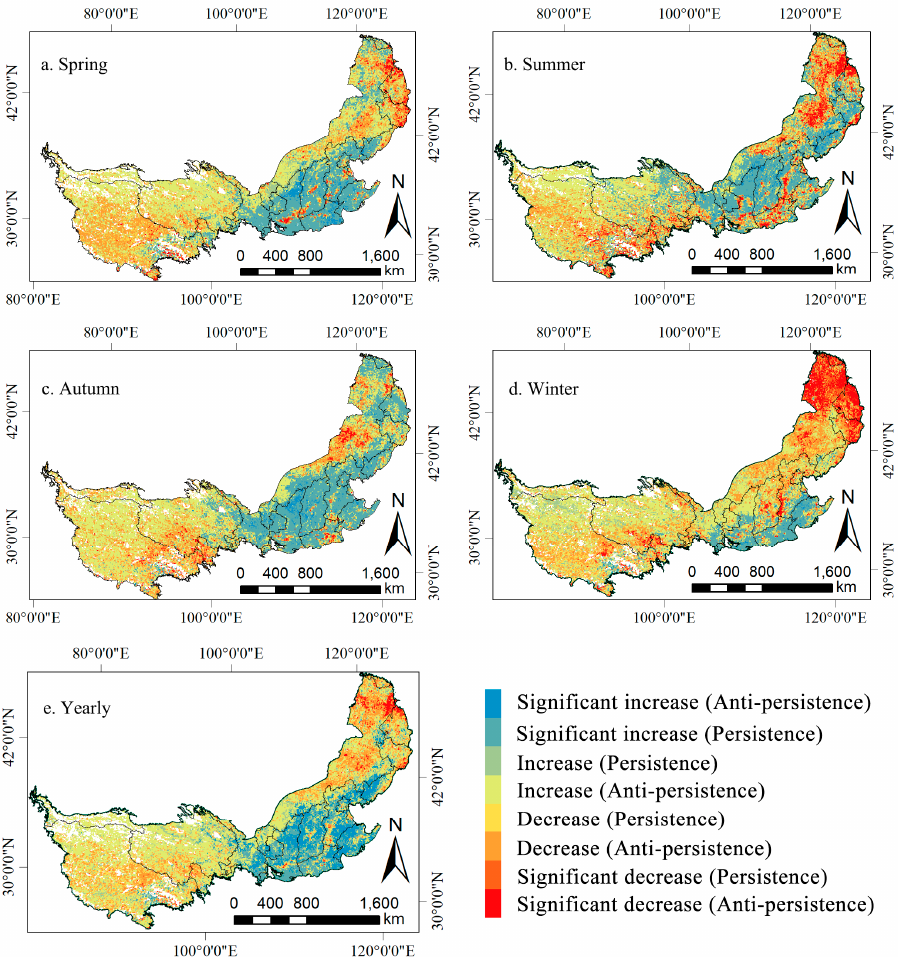
Figure 5. Persistence of the change trends of NDVI on annual and seasonal scales (a – e).